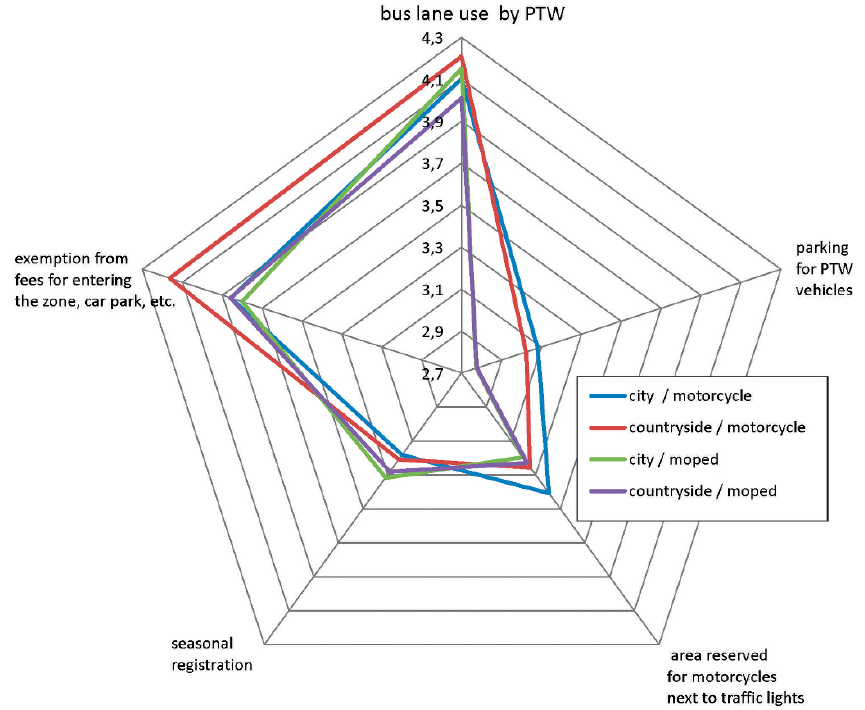
Figure 10. Respondents’ evaluation of possible PTW promotion activities.